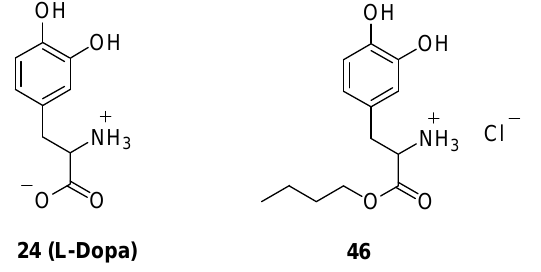
Figure 15. Chemical structures of L -DOPA and its ester